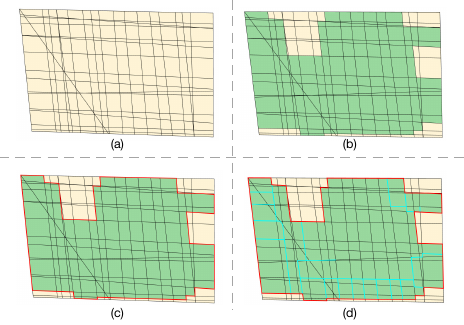
Figure 4. Floorplan extraction: a) cell decomposition; b) room labeling; c) outer wall extraction; d) inner wall extraction.